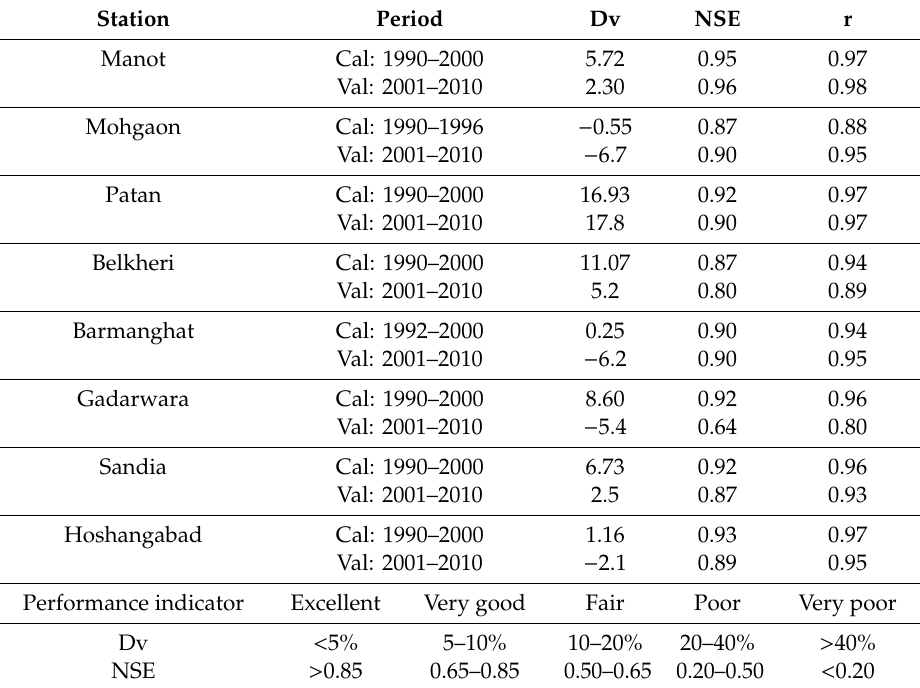
Table 4. Model performance statistics at the eight gauges for the calibration and validation periods.